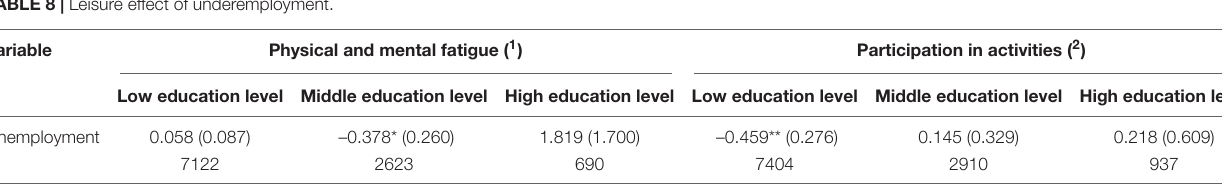
TABLE 8 | Leisure effect of